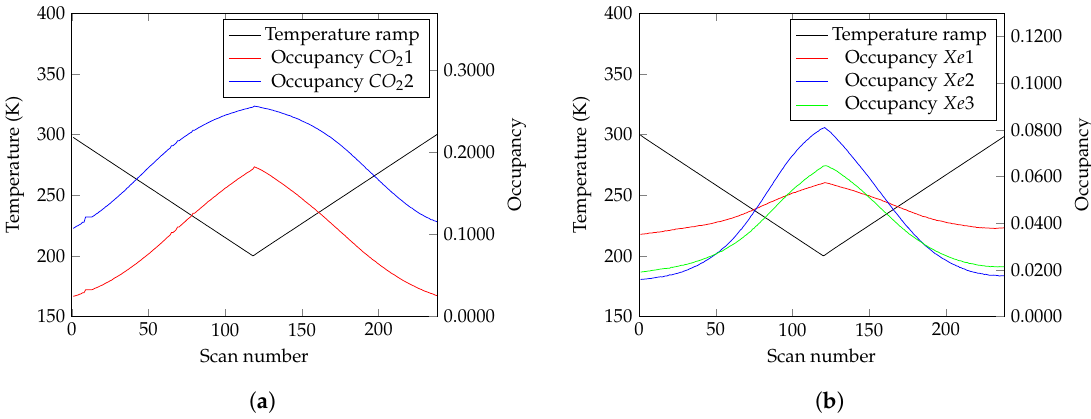
Figure 2. Occupancy variations of CO 2 . ( a ) CO 2 and ( b ) Xe occupancy.